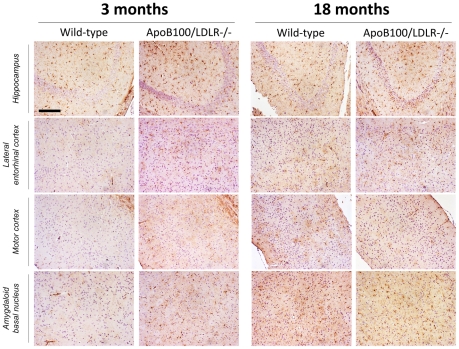
Astrogliosis in young and aged wild-type and transgenic mice.GFAP staining of coronal sections (1.58 mm from bregma) of the left (contralateral) hemisphere of a mouse brain from each of the age/genotype different groups. The hippocampus and three areas of the cortex are represented, showing several nuclei of the temporal lobe cortex, such as the lateral entorhinal, ectorhinal, the perirhinal and temporal-association cortices, the primary and secondary somatosensory cortices, the lateral parietal association cortex and visual cortex, and the cortical amygdaloidal nucleus and amygdalohippocampal area. Scale bar: 100 µm.